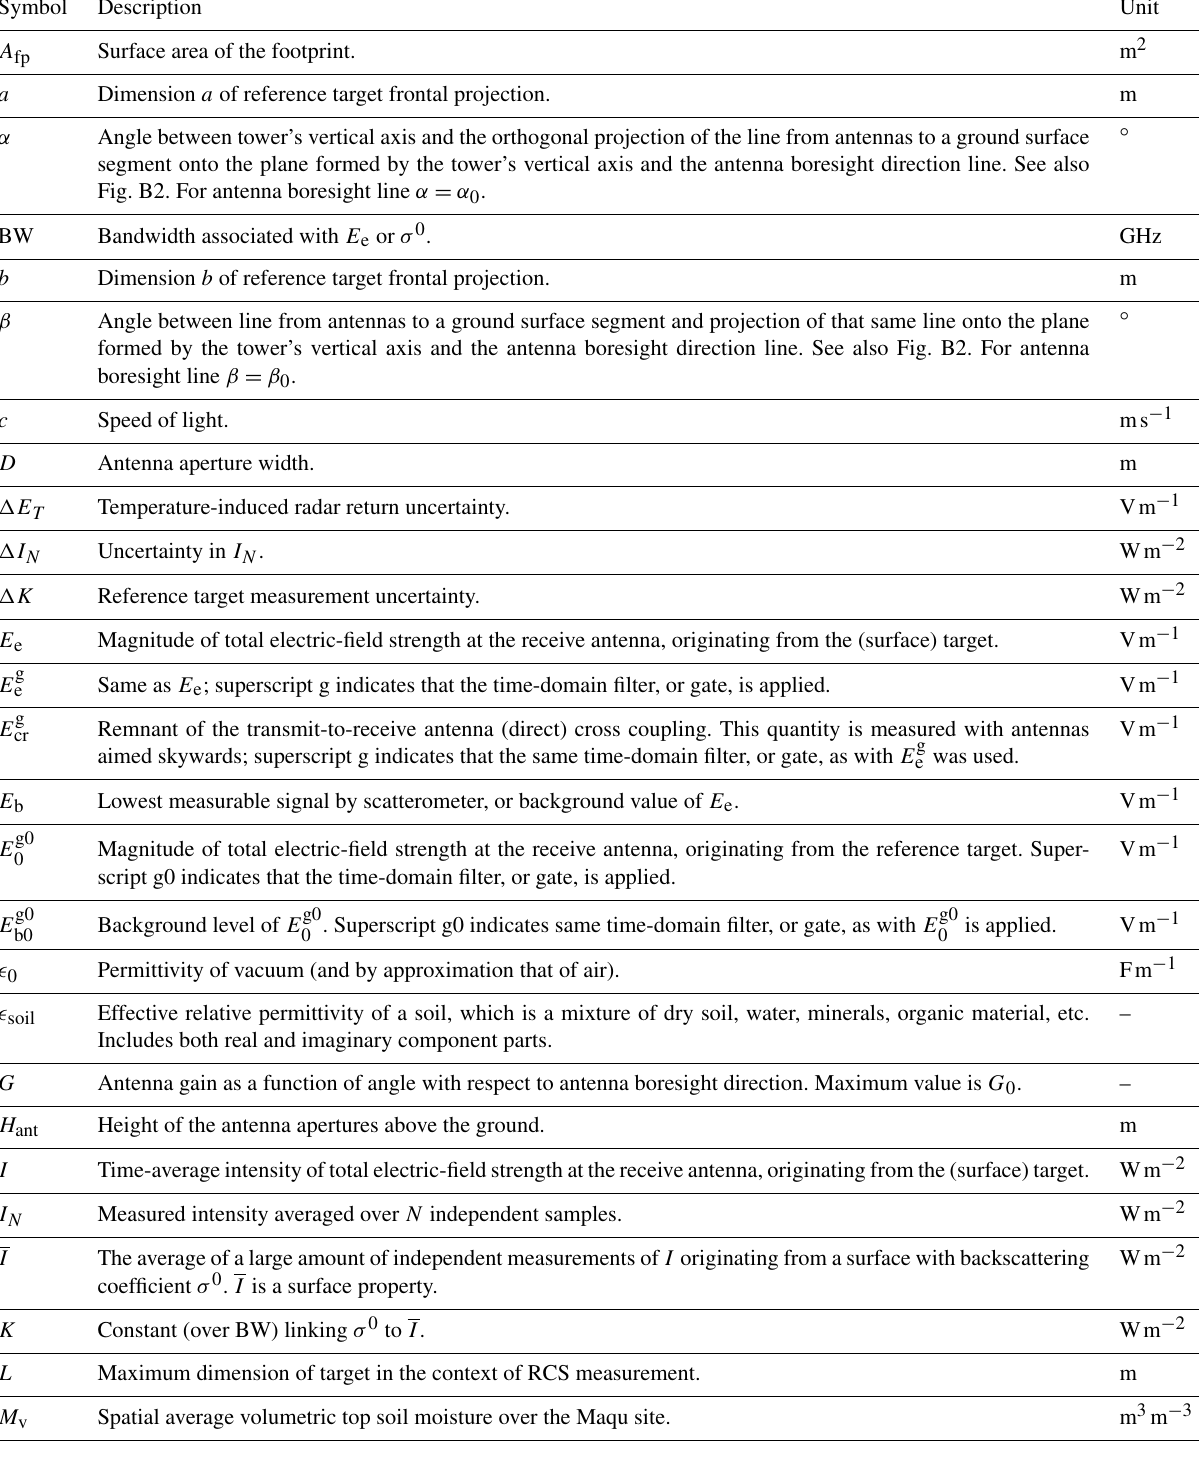
Table H1. List of symbols.